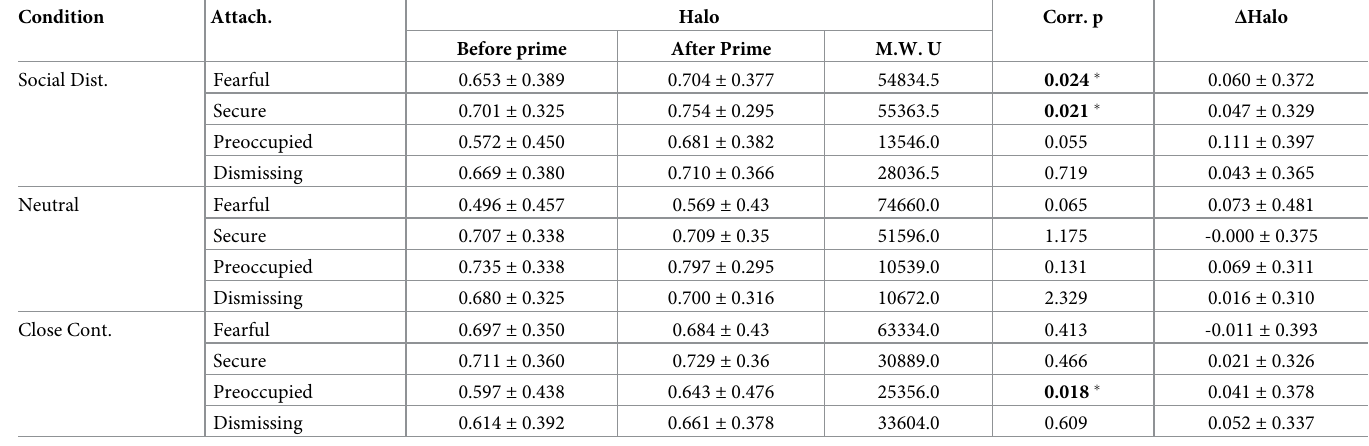
Table 3. Average strength of the Halo before and after the presentation of a prime, post-hoc comparison by mean of a Mann–Whitney U test (Bonferroni corrected), and average difference between the strength of the Halo before and after the presentation of a prime ( Δ Halo), by condition and attachment style. Condition